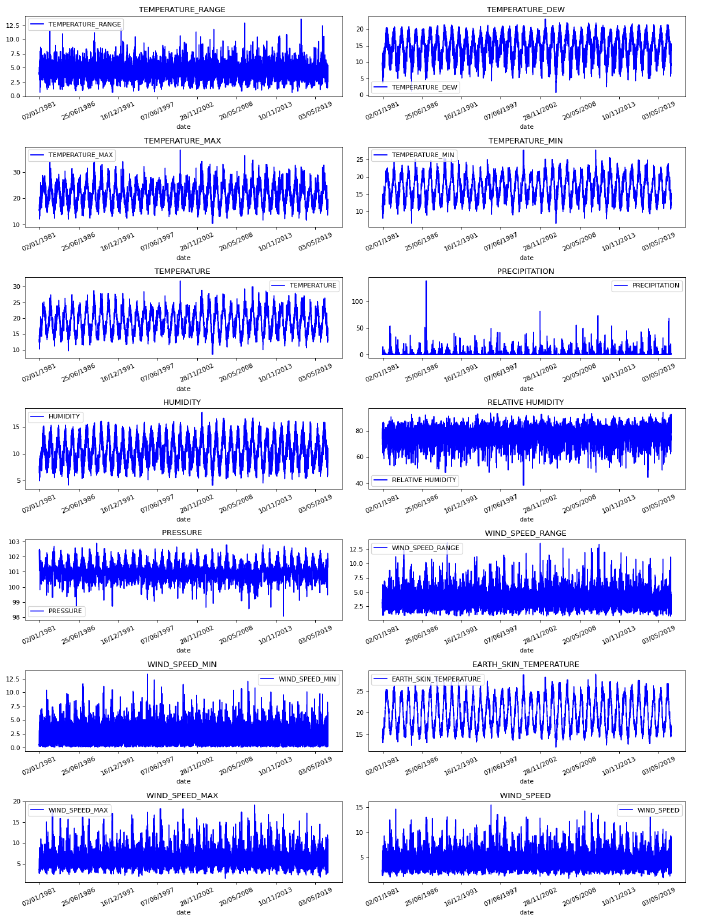
Figure 8. Exemplary plots of Temperature range, Temperature dew point, Temperature Max, Temper- ature Min, Temperature, Precipitation, Humidity, Relative humidity, Pressure, Wind speed range, Wind speed Max, Wind speed Min, Wind